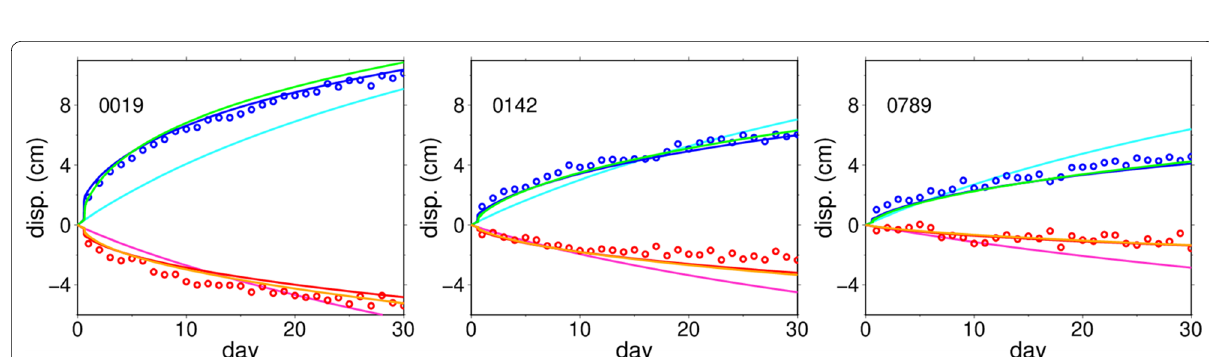
Fig. 11 Examples of postseismic time series in the application to real GNSS time series. The red and blue circles indicate the GNSS time series in X and Y directions. The pink, red, and orange lines are the theoretical time series in the X direction calculated by using the first-guess values, the optimum values when only frictional parameters are optimized and the optimum values when frictional parameters and initial values are simultaneously optimized, respectively. The light blue, blue, and green lines indicate the corresponding theoretical time series in the Y-direction. The locations of the GNSS stations are indicated in Fig.